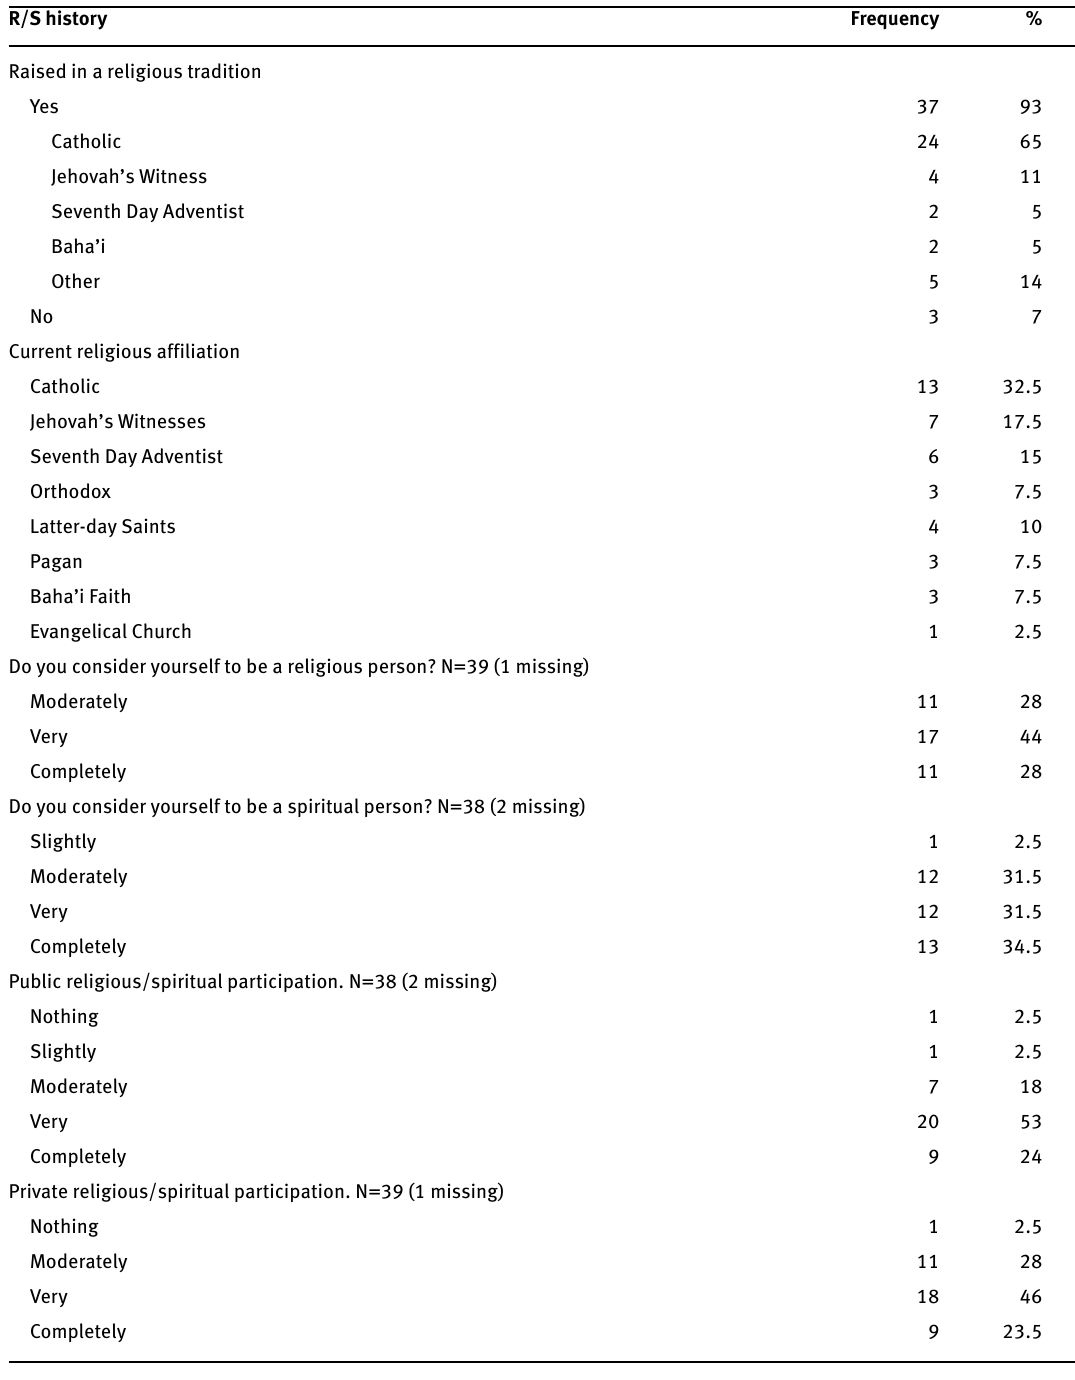
Table 4: Religious and Spiritual characterisation of the sample ( N =40) R/S history Frequency